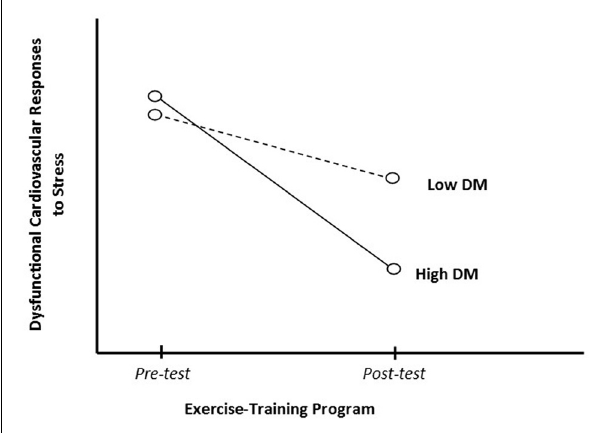
FIGURE 3 | Dispositional mindfulness (DM) as moderator of the physical fitness effects on cardiovascular responses to stress.